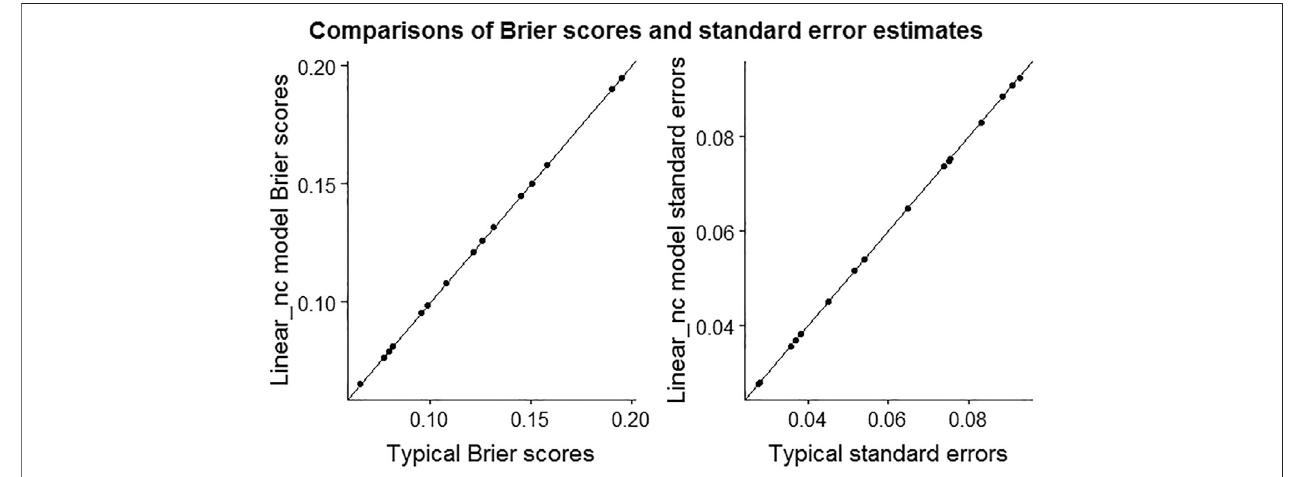
FIGURE 1 | The scatter plots of Brier scores and standard error estimates from typical and Linear_nc model based